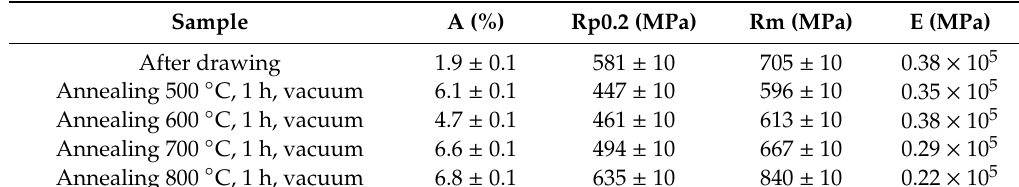
Table 1. Data on mechanical testing of wire depending on heat treatment.